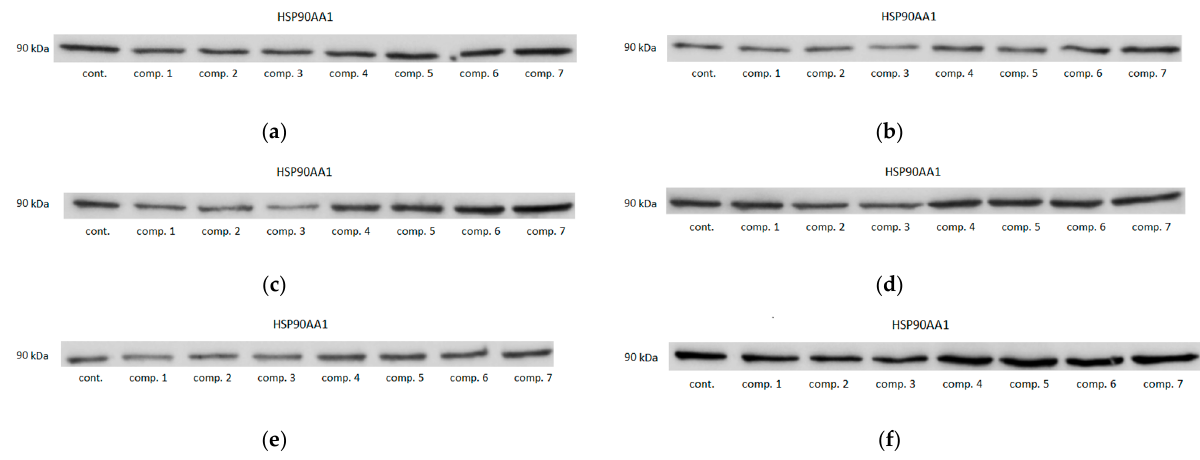
Figure 8. Effect of oxicams on HSP90AA1 protein expression in colorectal adenocarcinoma cell lines-exemplary blots: ( a ) in Caco-2 treated with 50 µM oxicams; ( b ) in Caco-2 treated with 200 µM oxicams; ( c ) in HCT 116 treated with 50 µM oxicams; ( d ) in HCT 116 treated with 200 µM oxicams; ( e ) in HT-29 treated with 50 µM oxicams; ( f ) in HT-29 treated with 200 µM oxicams. Cont., control; comp., compound.